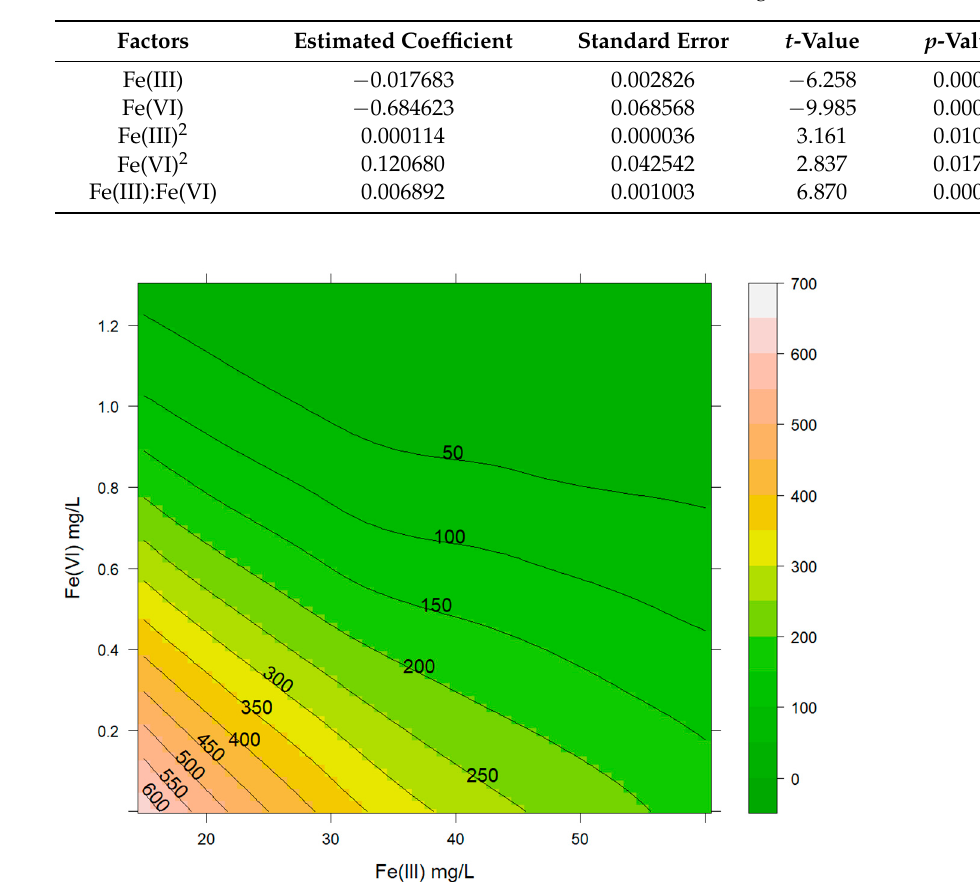
Table 2. t -test coefficients for a Quadratic Polynomial Regression Model with interaction that explains the final arsenic concentration at the initial As(III) concentration of 1 mg L − 1 .